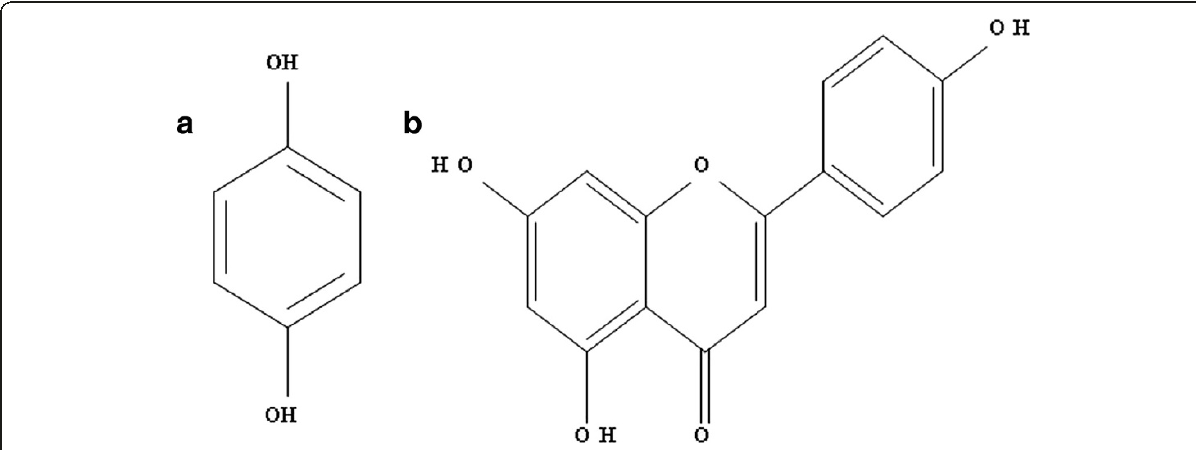
Figure 4 The formula structure of the two free radical scavenging active compounds in bee pollen: (A) hydroquinone (compound I) and (B) 7- O -R-apigenin (compound